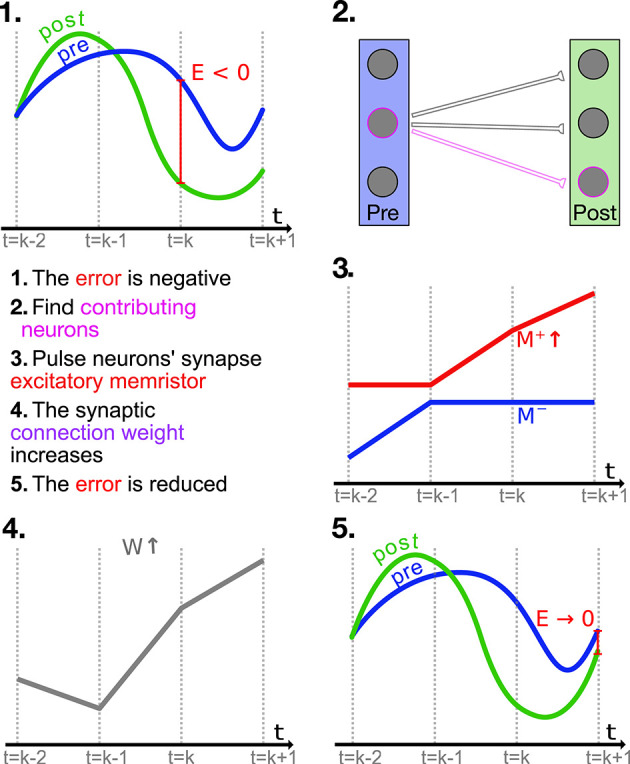
High level example (not to scale) of how the mPES learning rule minimizes the error E between the pre- and post-synaptic representations. At time t = k the neurons contributing to making the relevant component in error E negative are found, and the weights connecting them are adjusted accordingly; this example focuses on one such synapse. The error is negative so the synapse of the identified neurons is facilitated by pulsing its positive memristor M+ to increase its conductance. The facilitation increases the future response of the post-synaptic neuron and this is conducive to reducing the error in the following timesteps. NB: The process is analogous for the PES learning rule, with the exception of step 3., as PES operates directly on the synaptic weights W.